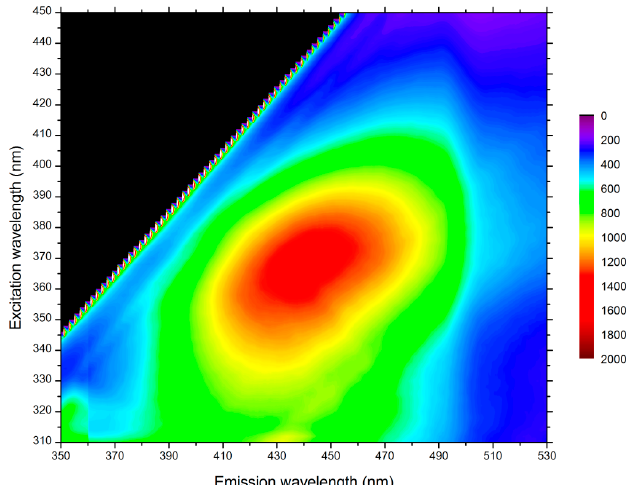
Figure 2. Autofluorescence contour map of poplar sample thin section. Maximum excitation occurs for wavelengths between 360 and 370 nm.